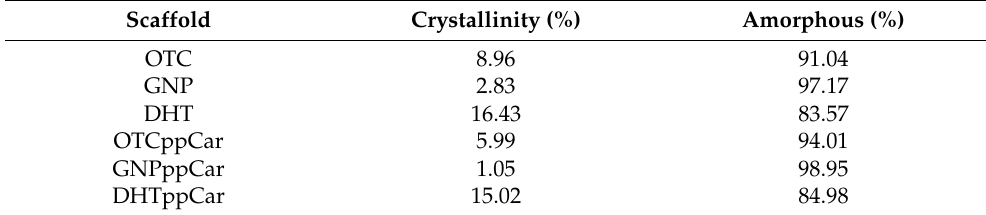
Table 3. The crystallinity and amorphous percentage of each scaffold from XRD. Scaffold Crystallinity (%) Amorphous